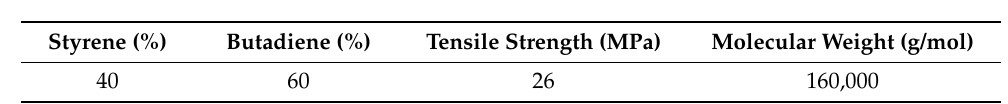
Table 2. Main characteristics of